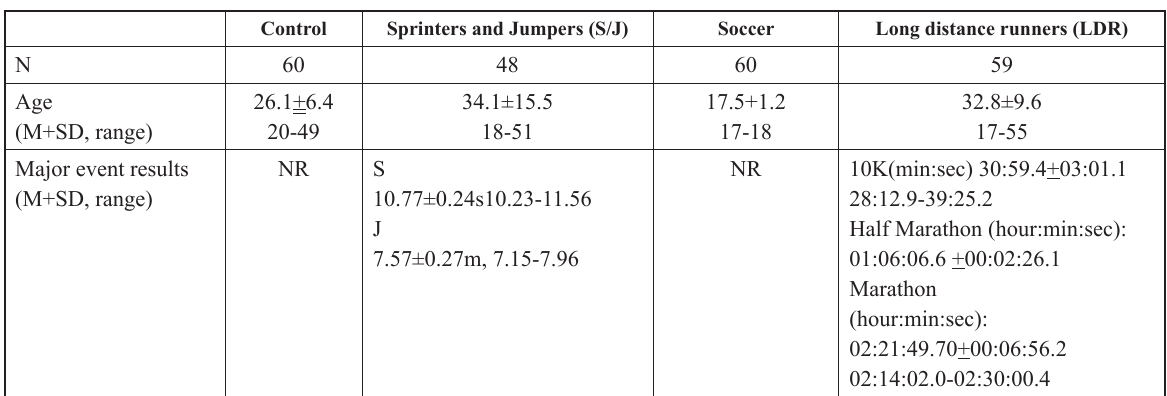
Table 1. Athletes’ data